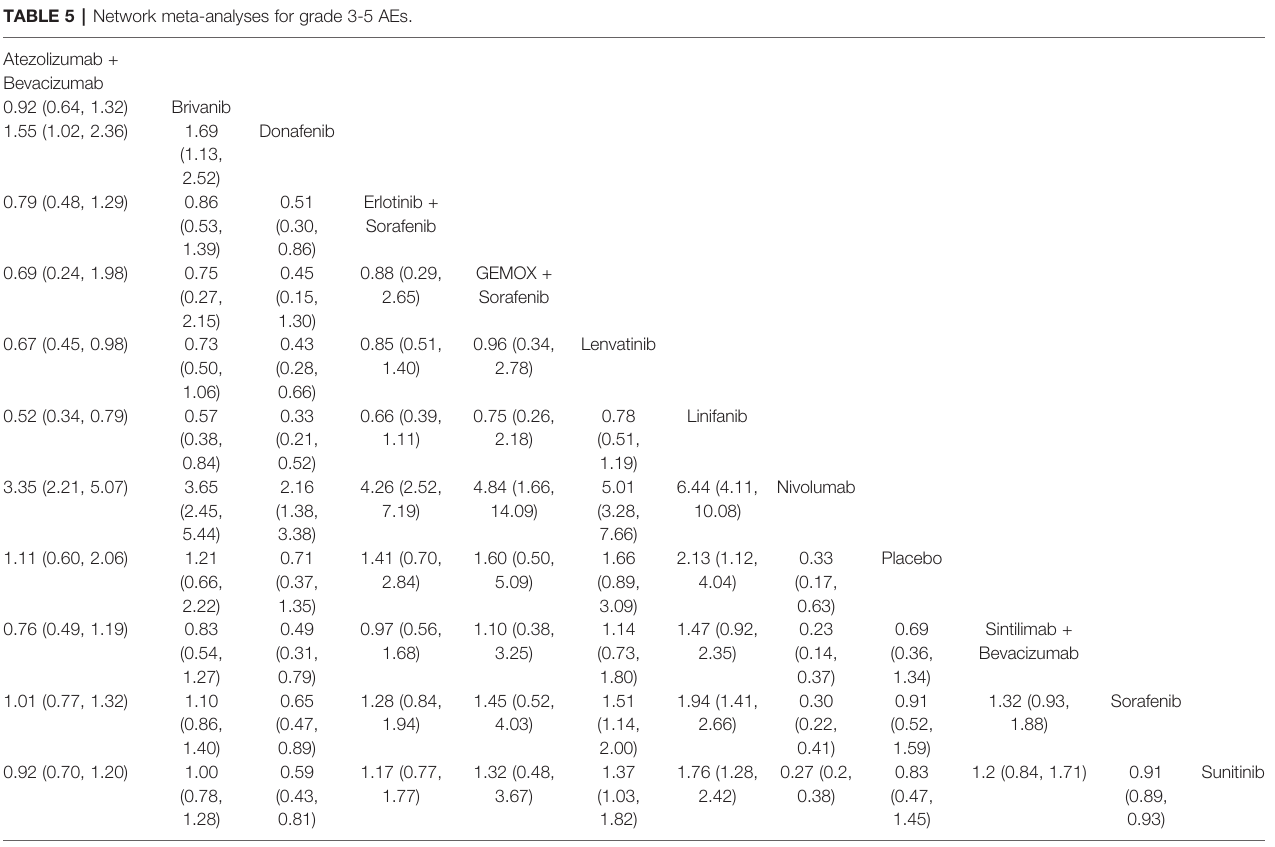
TABLE 5 | Network meta-analyses for grade 3-5 AEs. Atezolizumab +